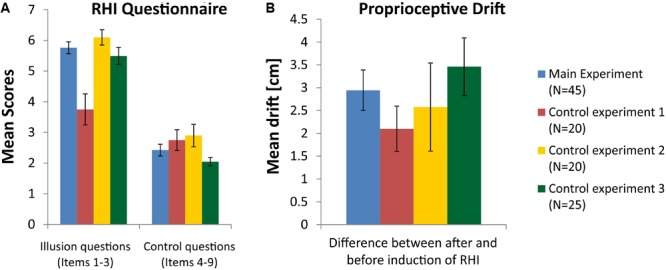
(A) Mean scores for the illusion questions (items 1–3) and control questions (items 4–9) in the RHI questionnaire (see Supplementary Table S1). (B) Mean differences of proprioceptive drift between measurements before and after induction of the RHI. Blue columns represent data from the main experiment, red columns for control experiment 1, yellow columns for control experiment 2, and green columns for control experiment 3. The data of all 45 participants entered the analysis in the main experiment, while control experiment 1 and 2 were completed by 20 subjects and conducted by examiner JH and control experiment 3 was completed by 25 subjects and conducted by examiner AB (error bars depict SE).